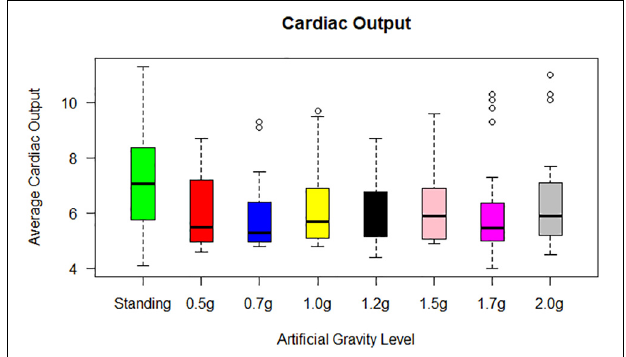
FIGURE 5 | Cardiac output (CO) for each of the 24 participants in the standing position (green) and at each artificial gravity (AG) load (denoted with a boxplot of a different color: red, 0.5g; blue, 0.7g; yellow, 1.0g; black, 1.2g; pink, 1.5g; magenta, 1.7g; gray,